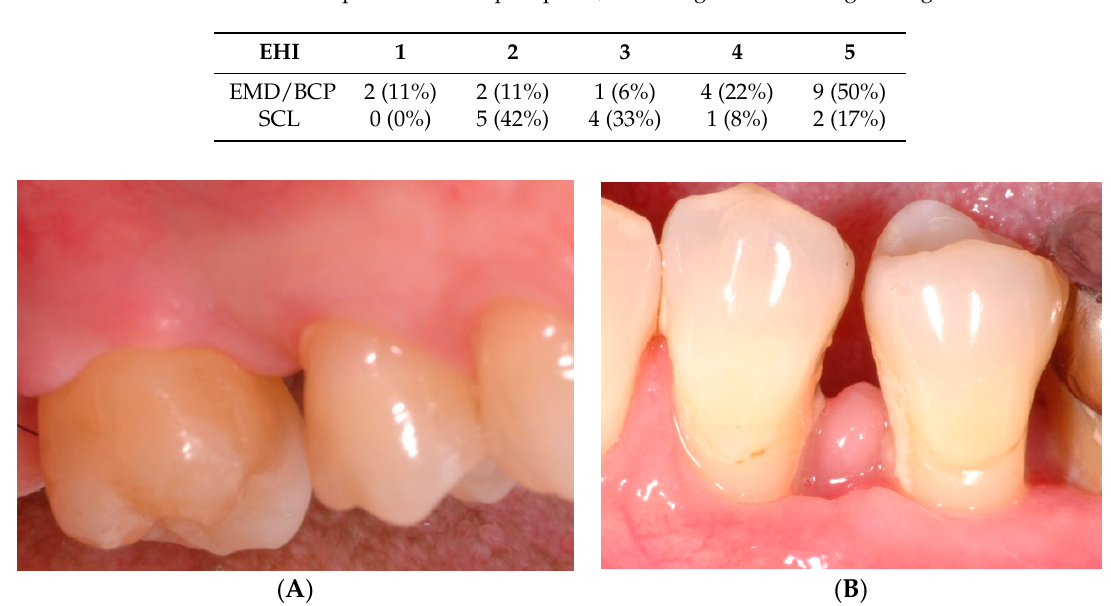
Table 2. Contingency table for wound healing in both groups, evaluated using the Early Healing Index (EHI). Significant difference favouring the SCL group ( p = 0.032, Pearson’s Chi 2 test). EMD/BCP: enamel matrix derivative/biphasic calcium phosphate; SCL: surgical crown lengthening.